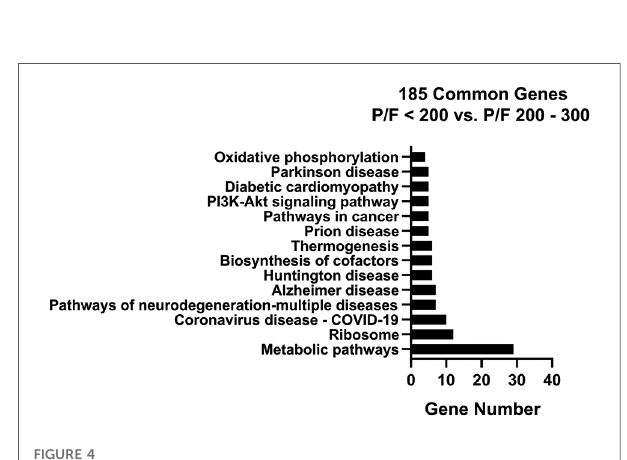
FIGURE 4 KEGG pathway analysis bar chart with number of genes for the overlapping 185 stability selected ranked genes from GSE147902 and GSE66099 comparing children with a P a O 2 /F i O 2 <200 with a P a O 2 / F i O 2 = ≥